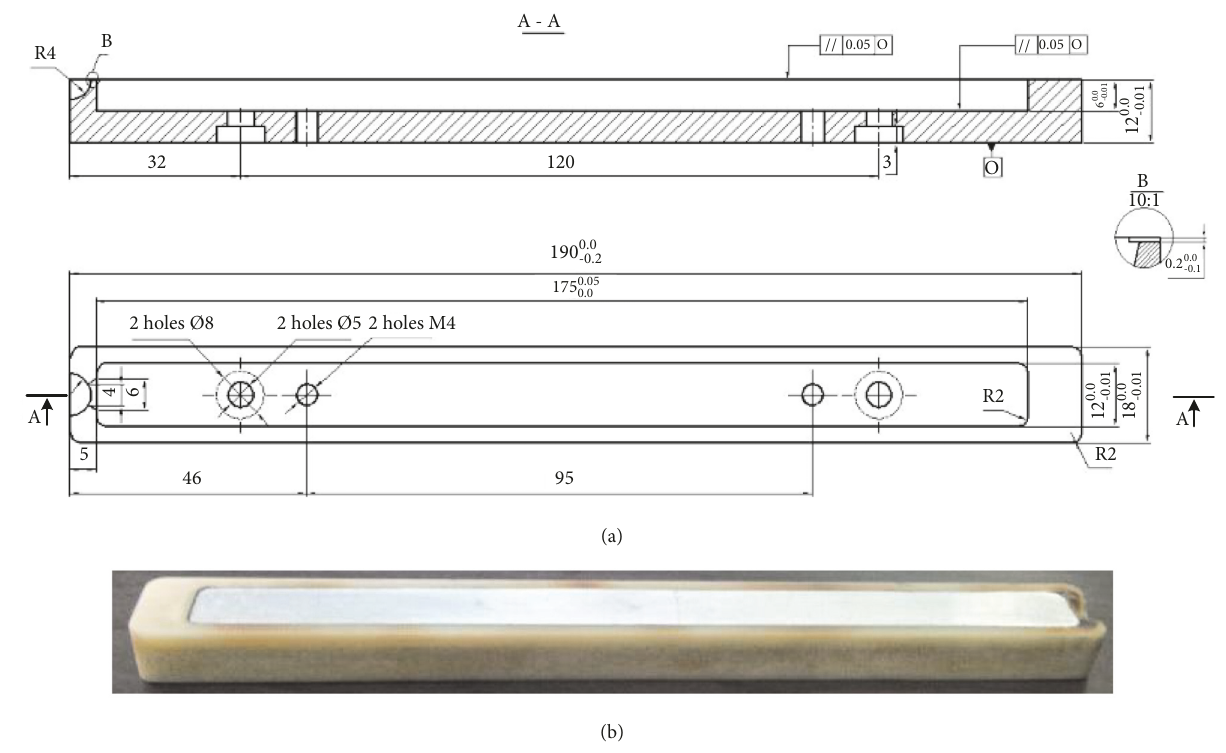
Figure 5: Mold insert for studying melt flow length. (a) Design of mold insert. (b) Experimental mold insert.